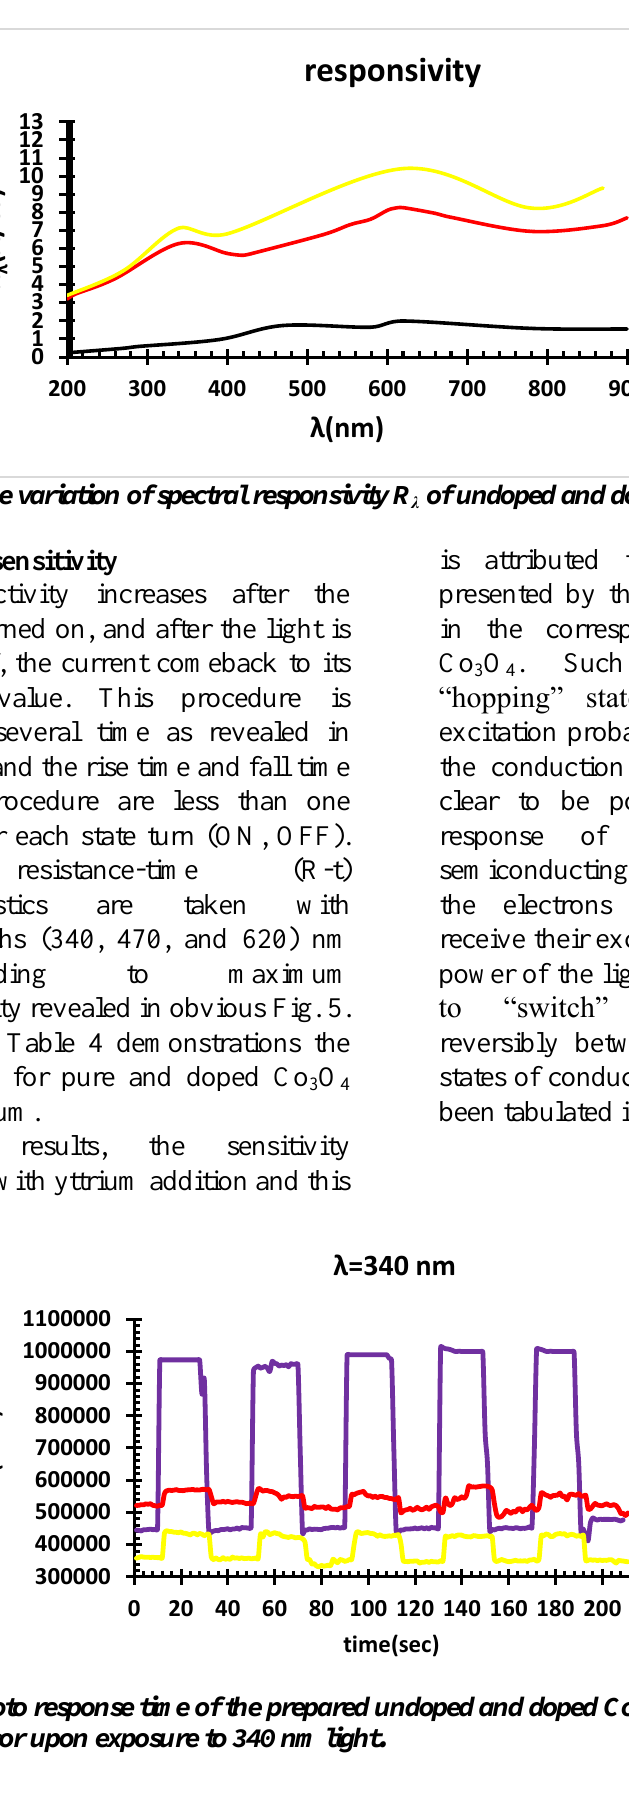
O with yttrium 3 4